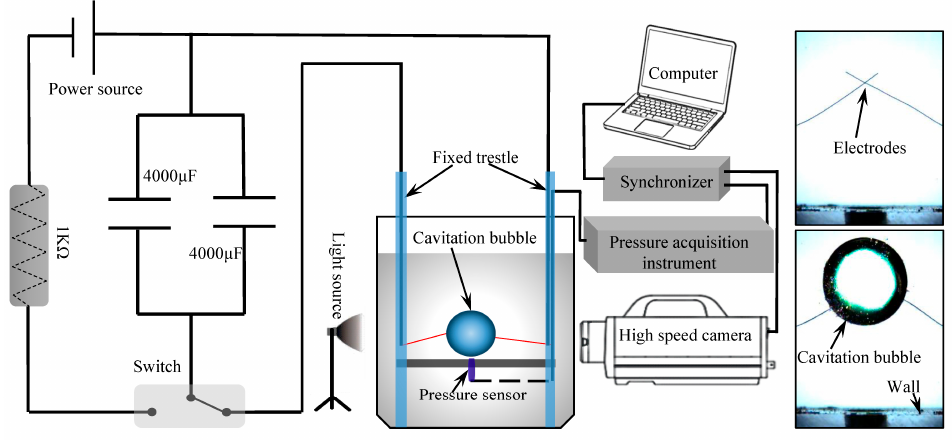
Figure 1. Schematic diagram of experimental facilities.